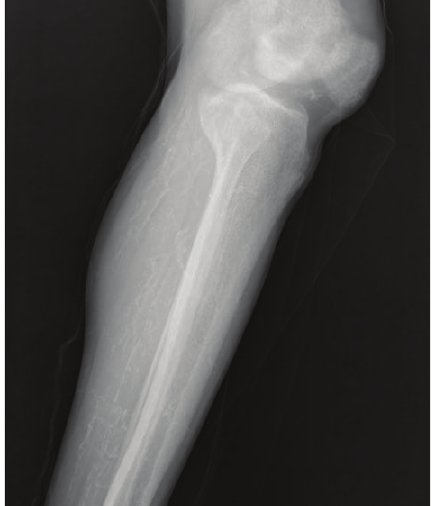
Figure 2: Diffuse small artery calcification of lower